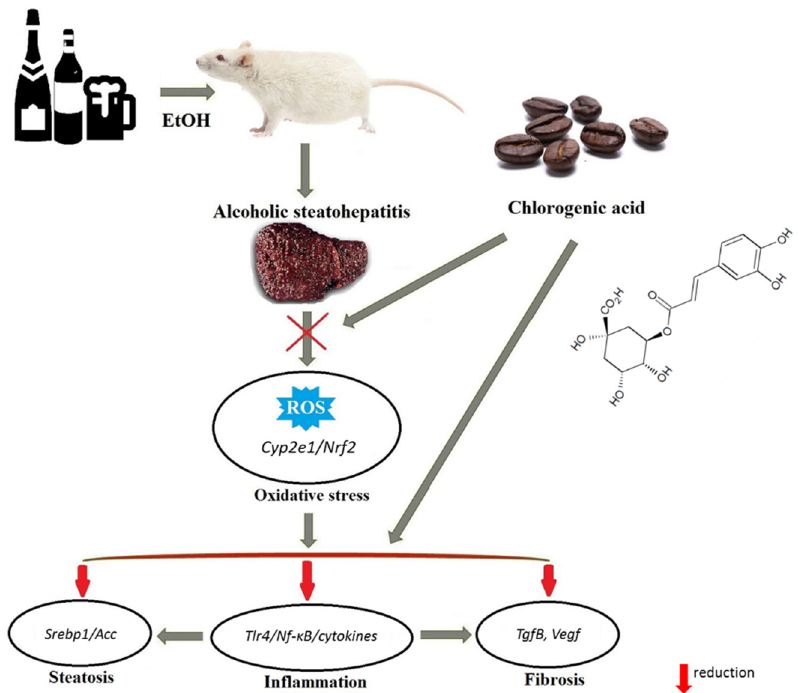
Figure 7. Chlorogenic acid effect on the steatohepatitis in rats with chronic alcohol intoxication—the proposed mechanism of action. CGA possesses protective activity against ROS generation, diminishes the release of inflammatory cytokines, and decreases the fibrosis and steatosis.